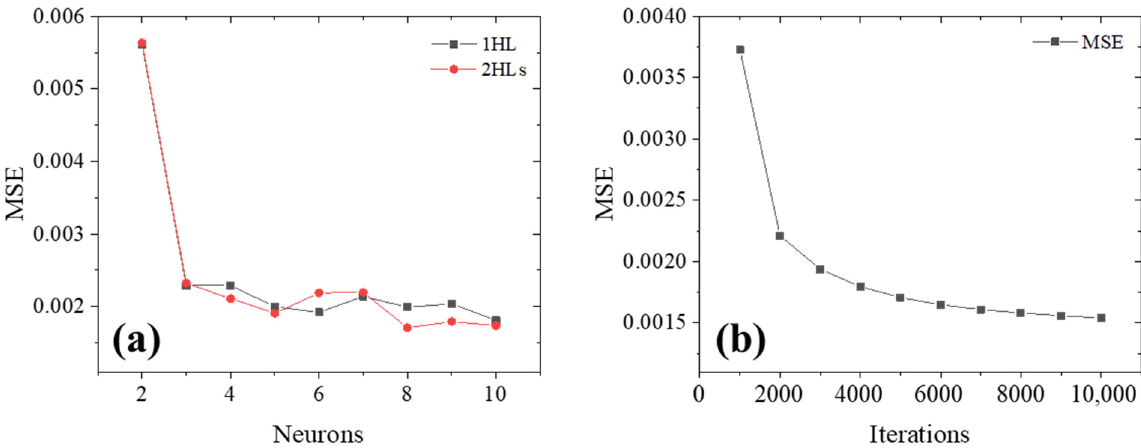
Figure 2. Variation in the MSE value as a function of the ( a ) number of hidden layers (HLs) and neurons and ( b ) number of iterations.